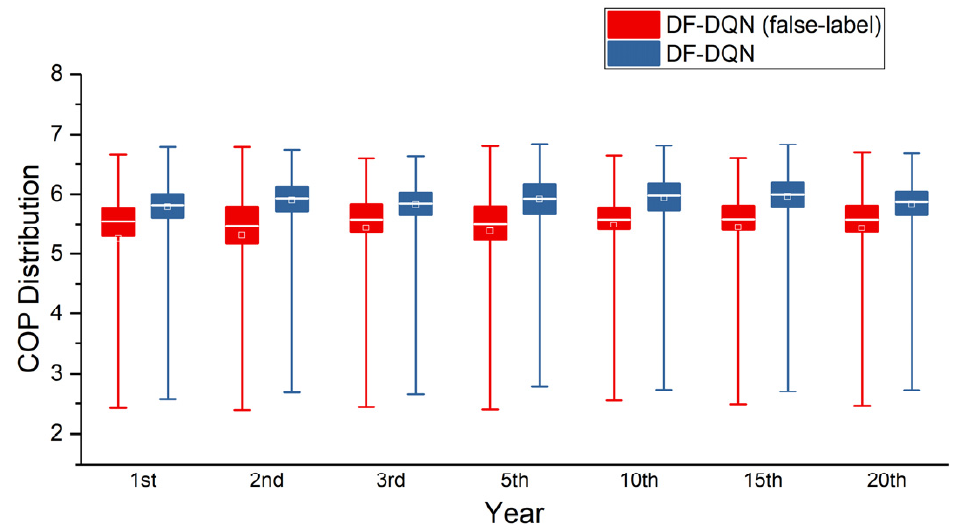
Figure 11. Comparison of COP between DQN and DF-DQN.